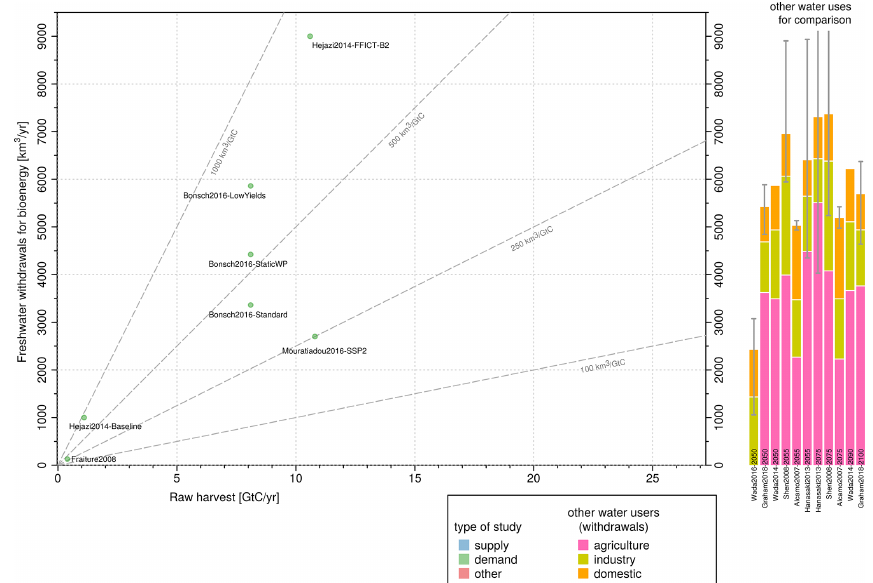
Figure A2. Analogous to Fig. 2 but for scenarios of reported values of global blue water withdrawals required for bioenergy production through biomass plantations. Scenarios are characterized by water withdrawals for bioenergy plotted against raw harvest (inferred from reported biomass based energy or negative emissions). They can provide ranges in water withdrawals or raw harvest (illustrated by boxes) or contain single values (depicted by circles). The type of study is marked by the colour. For contextualization, projections for other water uses (withdrawals) are shown to the right, together with their uncertainty ranges. Names of the bioenergy scenarios are constructed